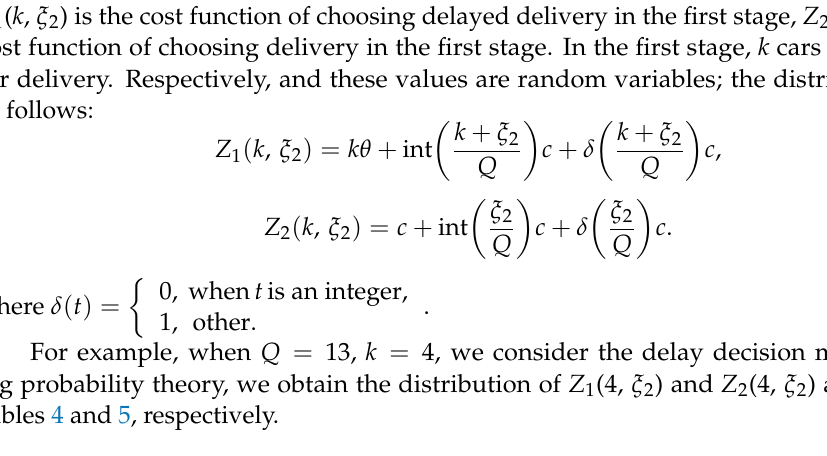
Table 4. The values of Z 1 (4, ξ 2 ) and Z 2 (4, ξ 2 ) ( Q = 13).